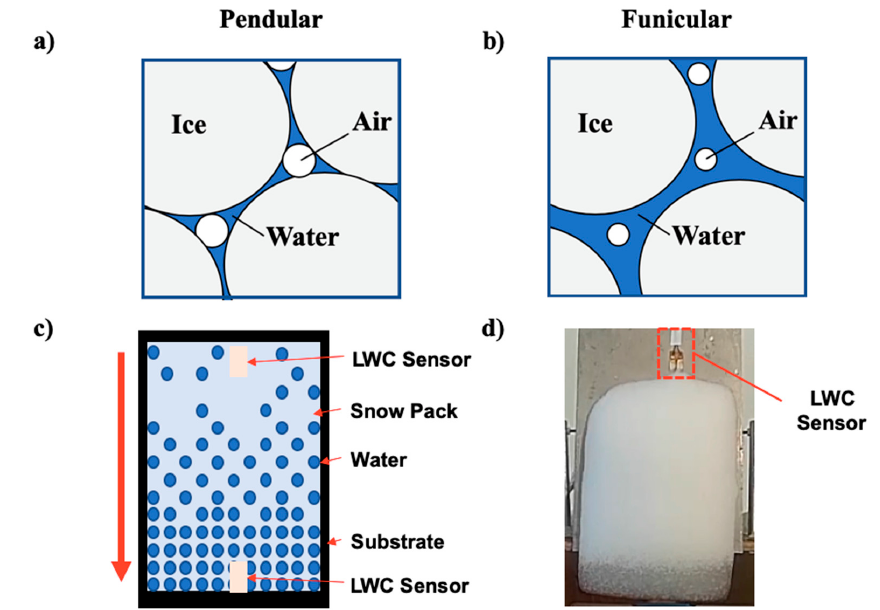
Figure 2. ( a ) Schematic of snow in the pendular regime; this typically occurs when the liquid water content in snow is below ~27%. Air and small amounts of water fill the gaps between the ice particles. ( b ) Schematic of snow in the funicular regime in which gaps between ice particles are mostly filled by liquid water with minimal air. At around 27% LWC in snow, the transition between pendular and funicular regimes occurs. ( c ) Schematically shows the liquid water content gradient that occurs in snow on an inclined substrate during shedding. The LWC sensors confirm this water movement in snow on inclined substrates. ( d ) A photo of a snow pile accumulated on an aluminum substrate, indicating migration of water to the bottom of the snowpack due to gravity. A liquid water content gradient forms, resulting in lower LWC at the top of the snowpack, when compared to its bottom. To prevent the LWC gradient from rapidly changing during measurements, a flat configuration is used to design a snow adhesion measurement setup as shown schematically in Figure 3 (see also Figure S3 for the photo of the setup). An LWC sensor is centered on the sample furthest from the shear wall. Initially, two sensors were placed on the sample during testing. Once it was verified that the LWC remained unchanged, a single sensor was used to maximize the surface area of the substrate in contact with the